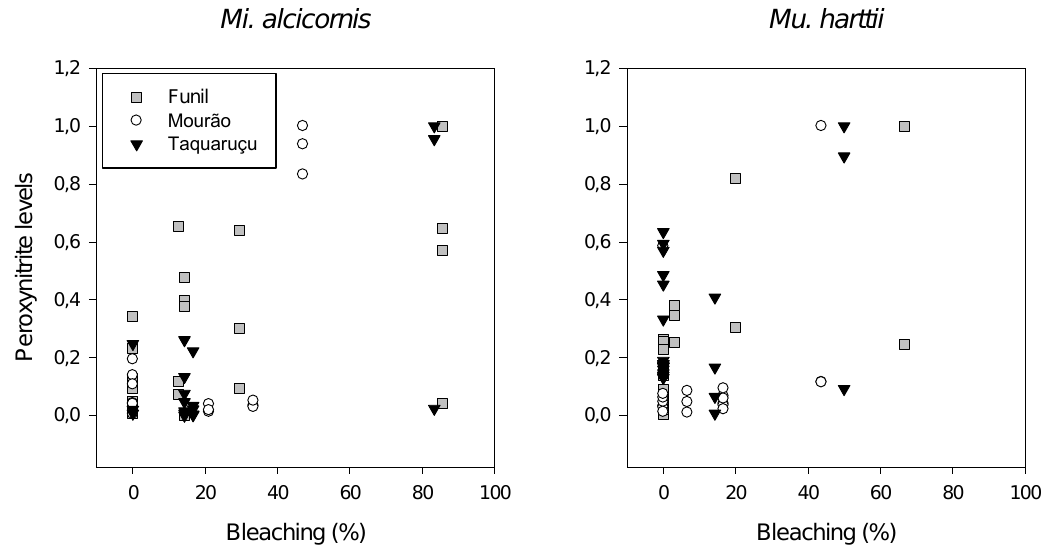
Figure 4. Correlation plot of peroxynitrite levels (standardized data) versus bleaching frequency for Millepora alcicornis and Mussismilia harttii, considering data from the three sites together. Highest peroxynitrite and bleaching levels were adjusted according the time lag observed for each of the sites, which varied from 0 to 30 days. A significant correlation was observed between ONOO − levels and bleaching intensity for Mi. alcicornis ( p < 0.001, Pearson correlation coefficient = 0.81) and Mu. harttii ( p = 0.001, Pearson correlation coefficient = 0.64).